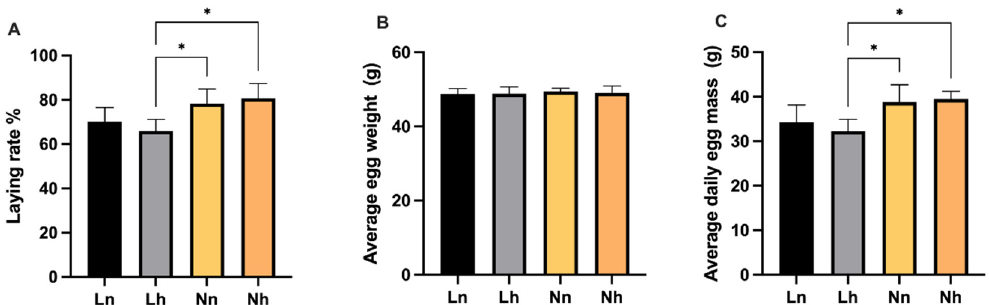
Figure 6. Effects of phosphorus restriction in brooding stage and subsequent recovery on laying performance of layers at 26 weeks of age. ( A ) Laying rate ( B ) Average egg weight ( C ) Average daily egg mass. Data are shown as mean ± SEM. * p < 0.05. Ln = group fed 0.13% nPP at 1–8 weeks and fed 0.39% nPP at 9–20 weeks; Lh = group fed 0.13% nPP at 1–8 weeks and fed 0.45% nPP at 9–20 weeks; Nn = group fed 0.45% nPP at 1–8 weeks and fed 0.39% nPP at 9–20 weeks; Nh = group fed 0.45% nPP at 1–8 weeks and fed 0.45% nPP at 9–20 weeks. n = 6 per group.